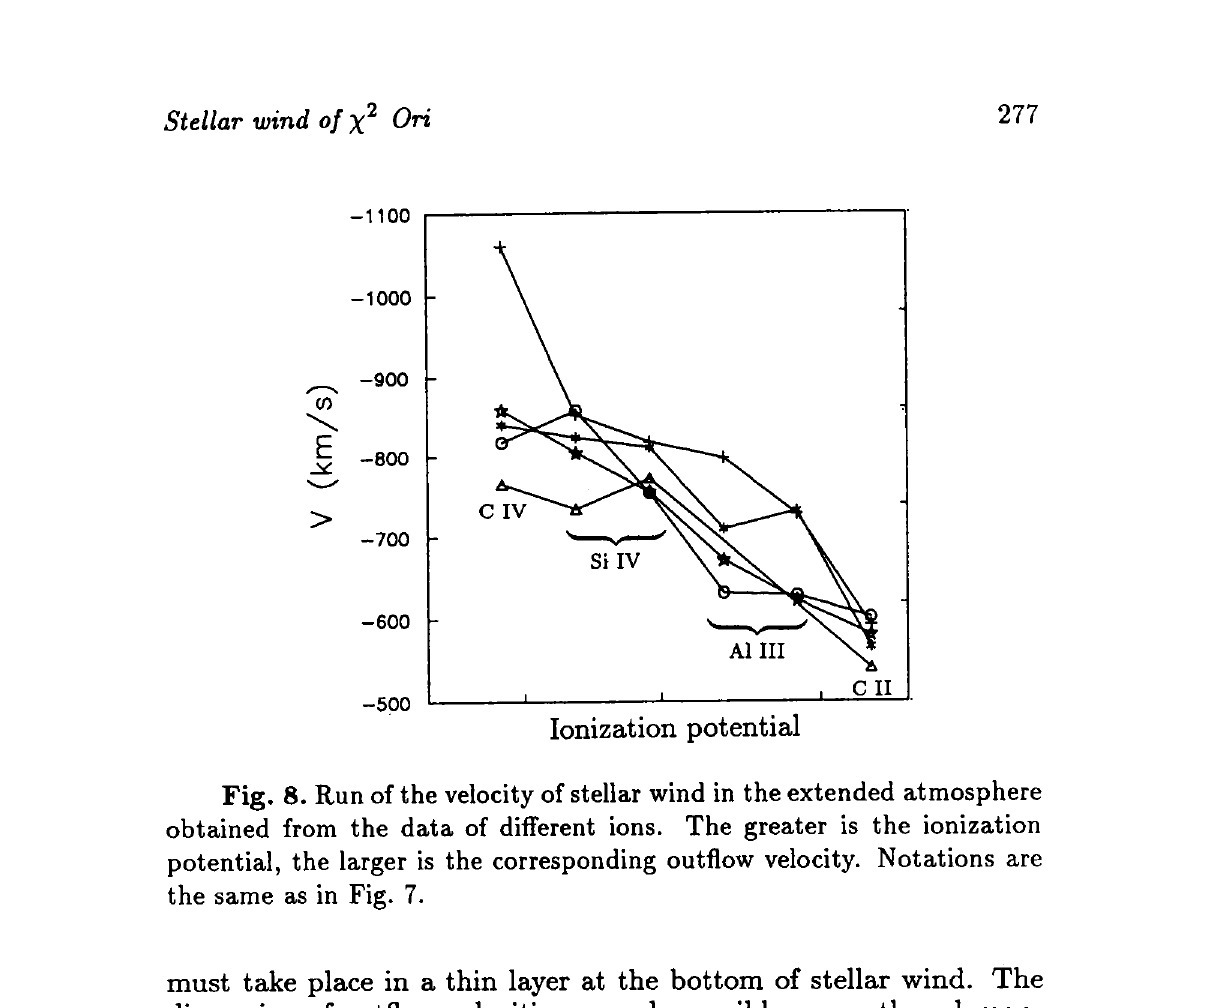
Fig. 8. Run of the velocity of stellar wind in the extended atmosphere obtained from the data of different ions. The greater is the ionization potential, the larger is the corresponding outflow velocity. Notations are the same as in Fig.